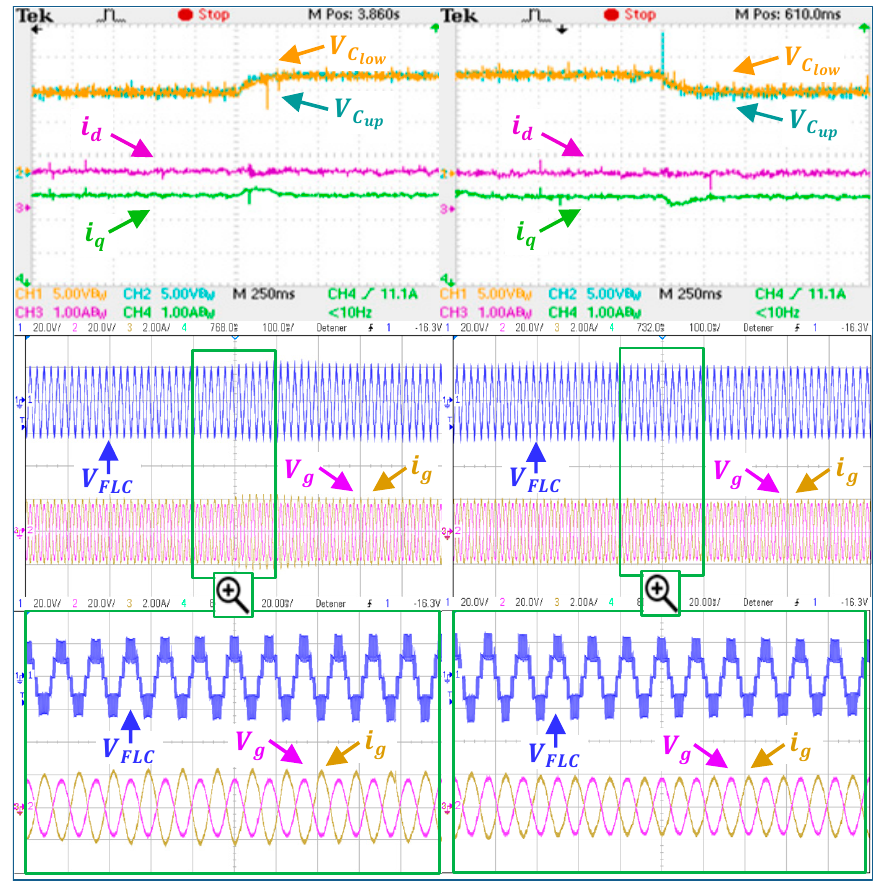
Figure 15. Performance of the voltage balancing strategy and the vector control for the proposed Figure 16. Fluke 43B-based power quality analysis of grid-tied SPFLC waveforms without the grid-tied SPFLC during a DC bus voltage step-change. activation of the DC-link split capacitors’ voltage balancing. ( a ) SPFLC output voltage V FLC and the resulting grid current i g from the vector control technique; ( b ) grid powers, grid factors, V g and i g ; ( c ) spectrum of V FLC ; and ( d ) spectrum of i g